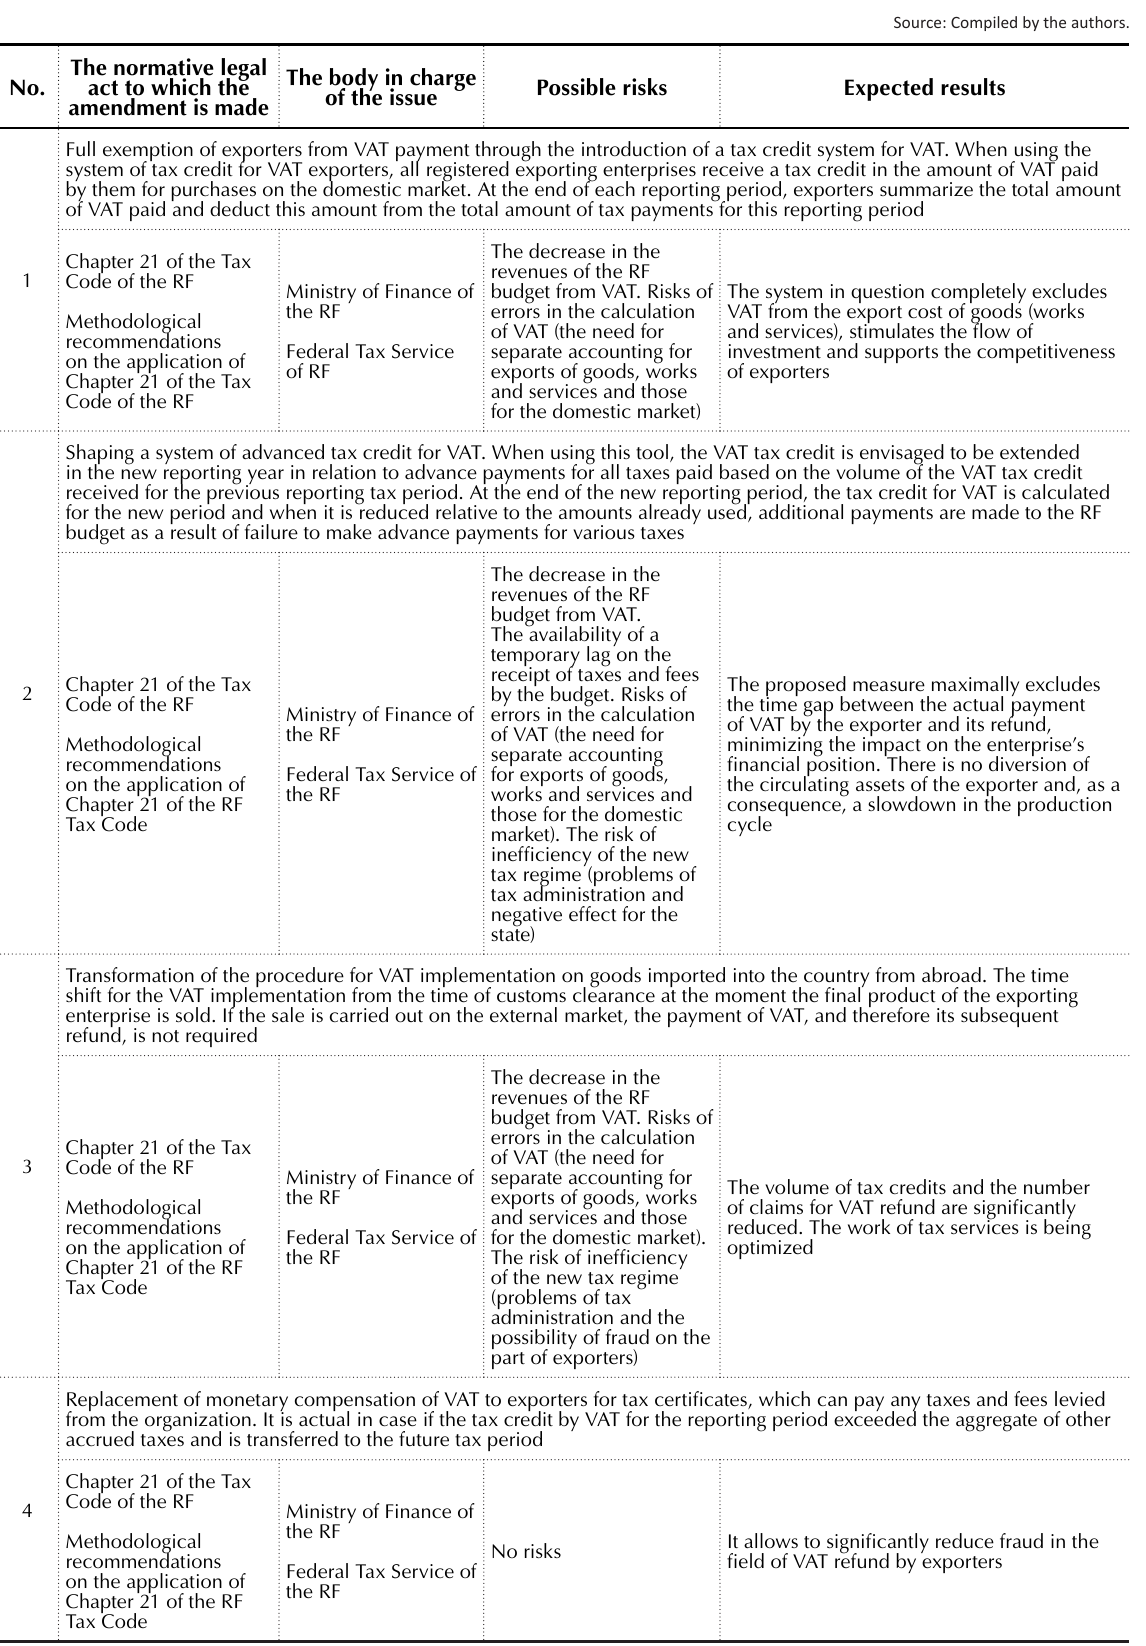
Table 2. Proposed measures of tax incentives for non-primary export in Russia